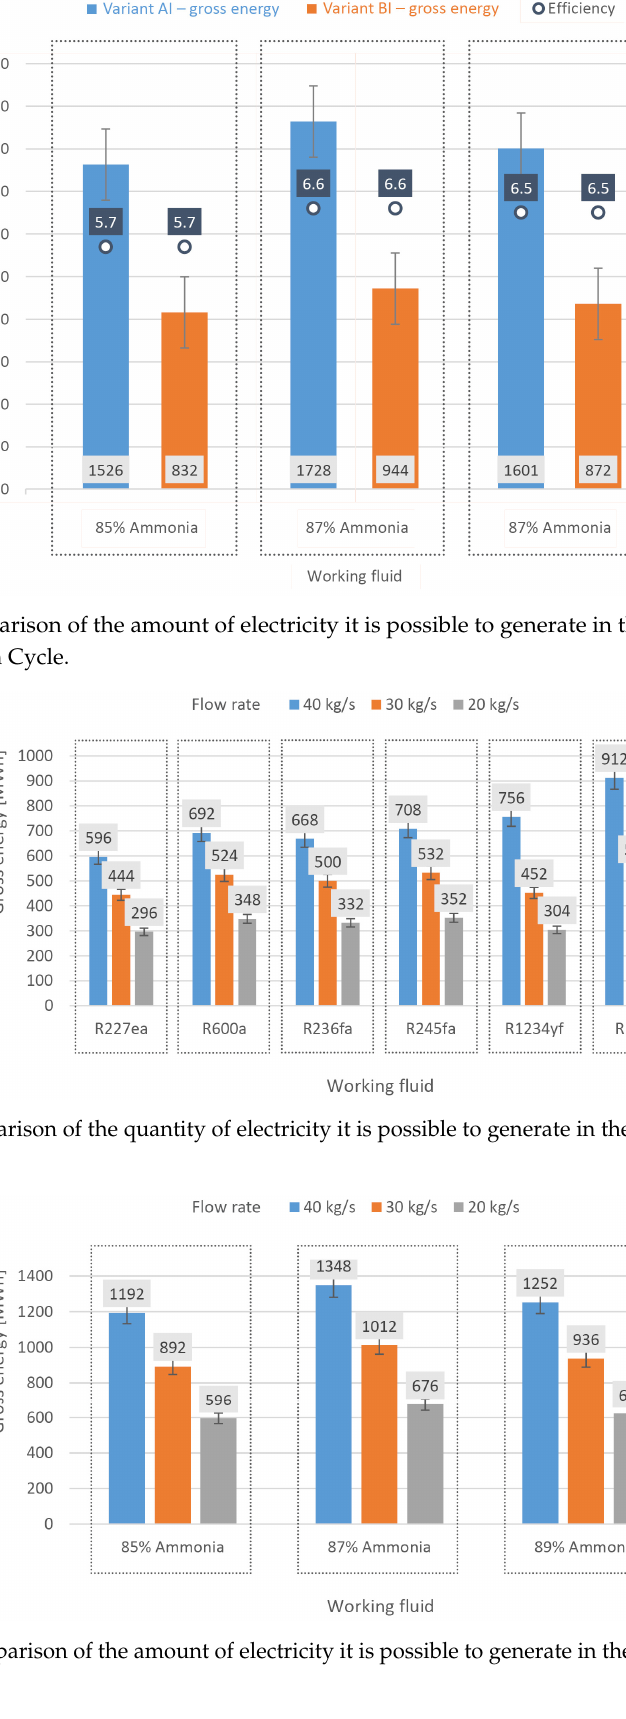
Figure 10. Comparison of the amount of electricity it is possible to generate in the AII variant using the Kalina Cycle.